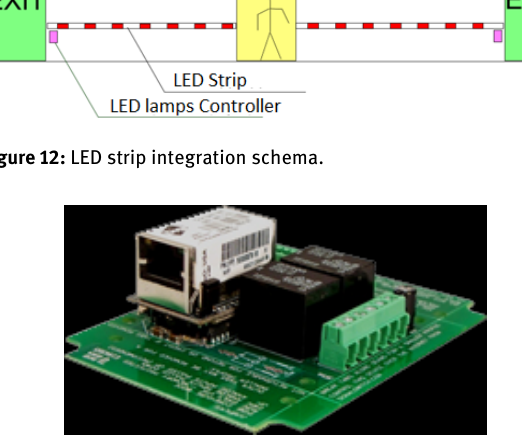
Figure 13: 2 Relay web